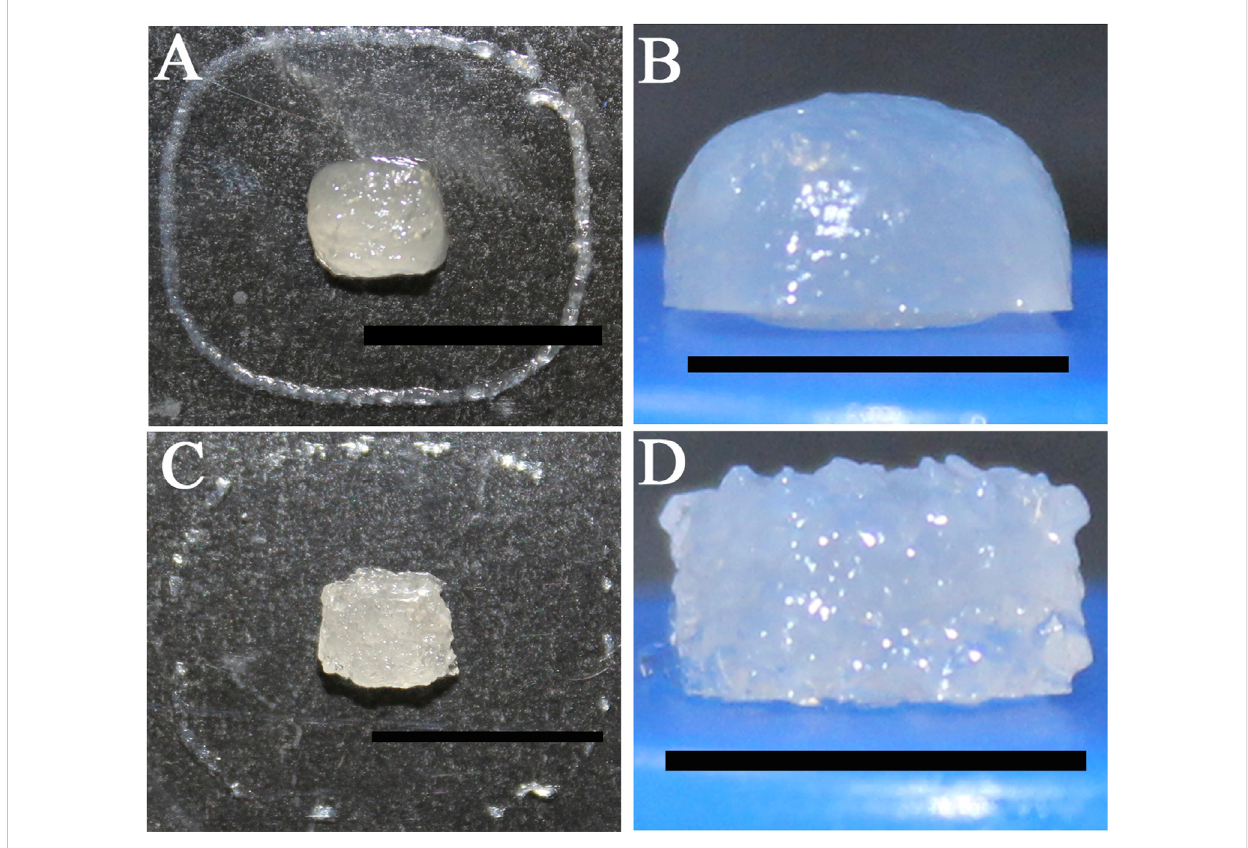
FIGURE 11 Constructbioprintedwithamixofbiopolymersatdifferentconcentrations.Bioinkcomprising4%alginateand3%gelatin (A,B) ,Bioinkcomprising4% alginate, 4% gelatin and post-printing crosslinking with 5 M calcium chloride (C,D) . Scale bar: 1 cm (B,D) ; 2 cm (A,C)